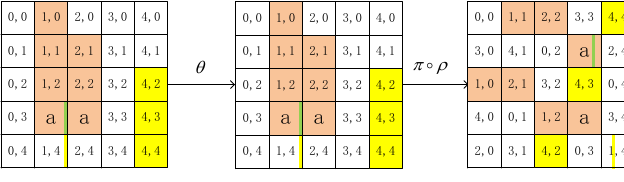
Figure 19: Attack on 5-round Ketje Jr